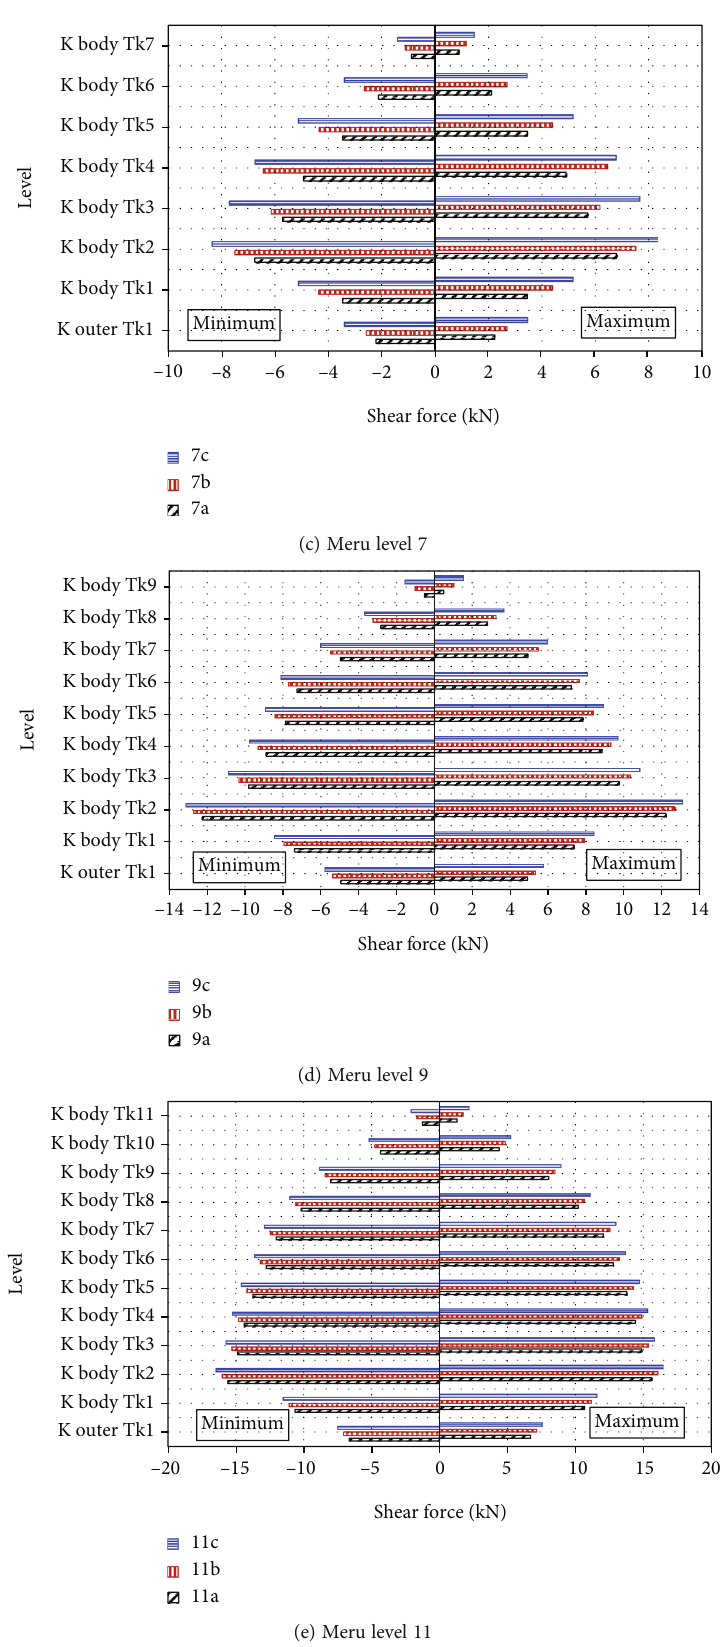
Figure 9: Column maximum shear force due to earthquake load direction X for Meru levels 3, 5, 7, 9, and